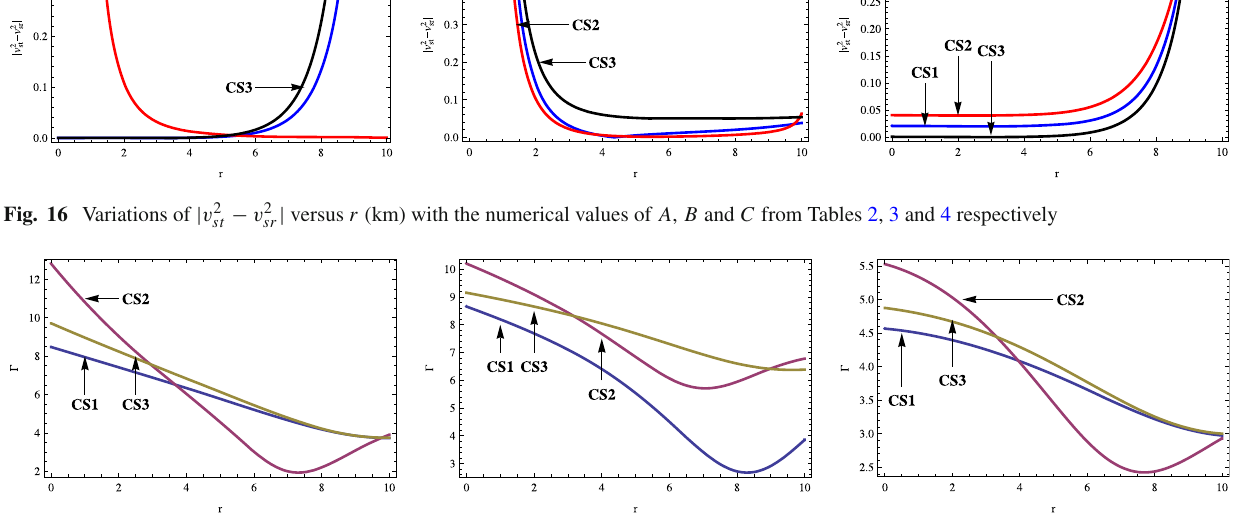
Fig. 17 Variations of (cid:8) versus r (km) with the numerical values of A , B and C from Tables 2, 3 and 4